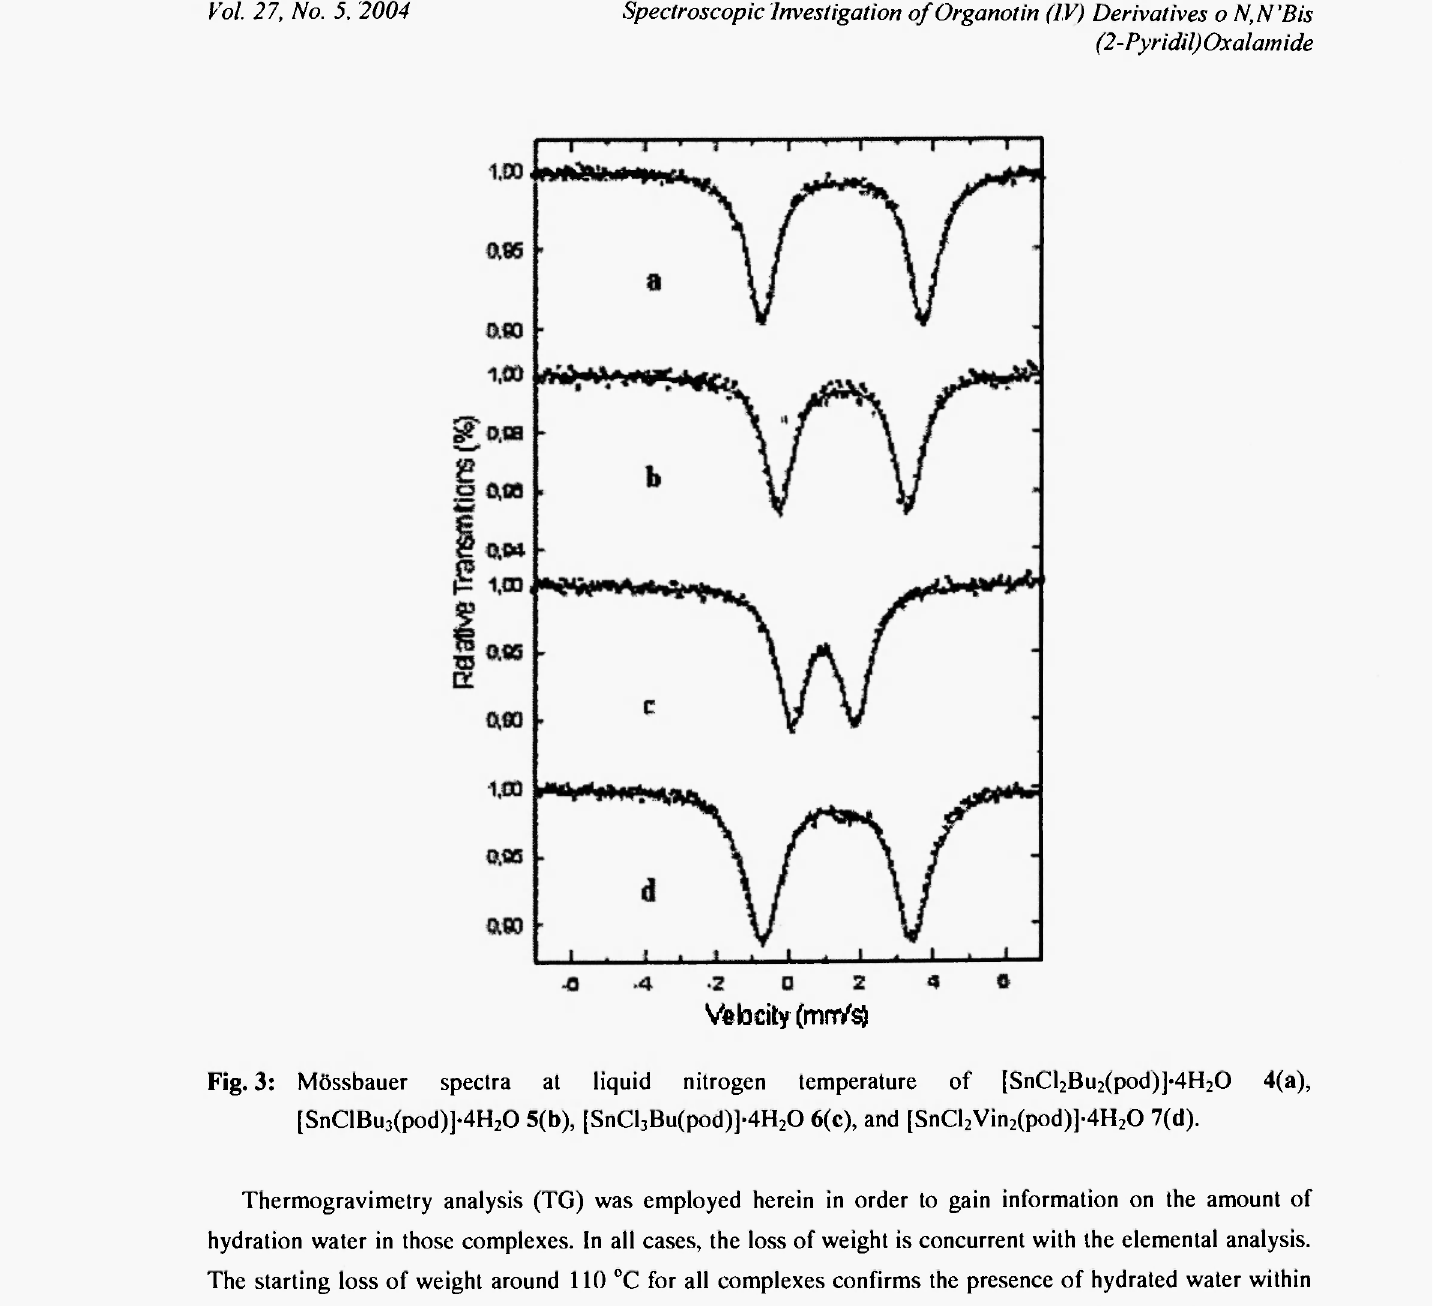
Fig. 3: Mössbauer spectra at liquid nitrogen temperature of [SnCl 2 Bu 2 (pod)]-4H 2 0 4(a), [SnClBu 3 (pod)]-4H 2 0 5 (b), [SnCl 3 Bu(pod)]-4H 2 0 6(c), and [SnCl 2 Vin 2 (pod)]-4H 2 0 7